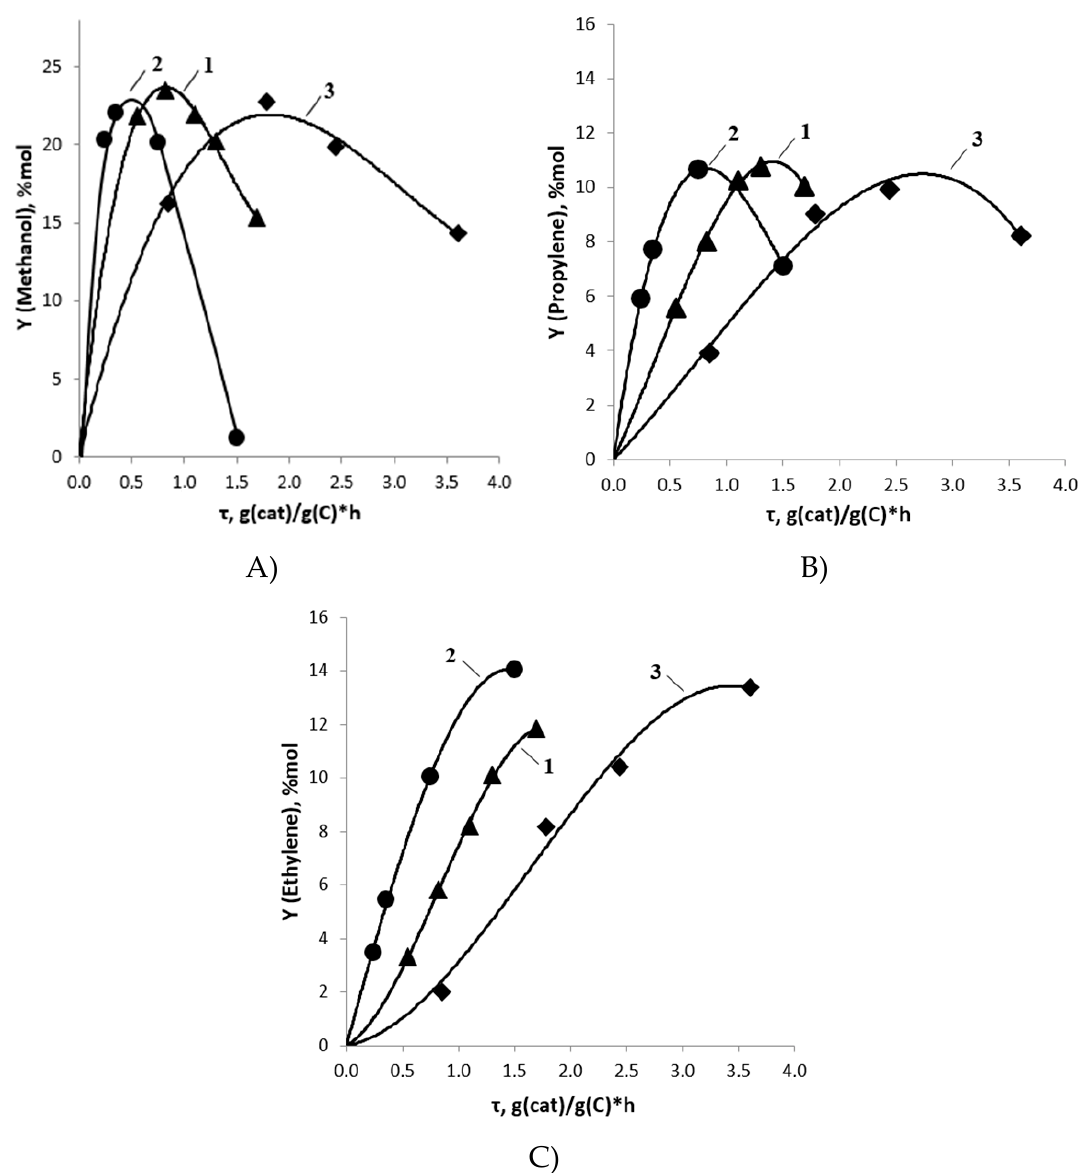
Figure 5. Product yields (Y, mol %) as a function of specific contact time ( τ , g(cat)/g(C)*h). 1—HZSM-5 / Al 2 O 3 ; 2—Zr-HZSM-5 / Al 2 O 3 ; 3—Mg-HZSM-5 / Al 2 O 3 . ( A ) methanol; ( B ) propylene; ( C ) ethylene.